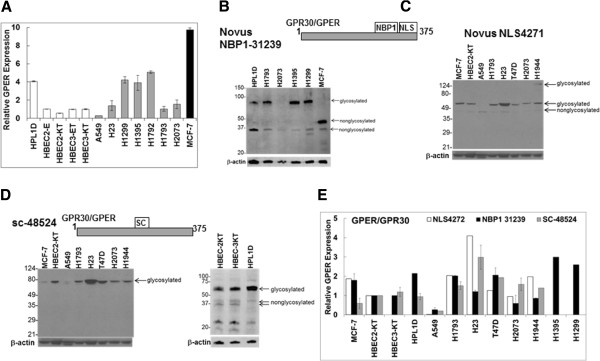
GPER/GPR30 expression in normal lung cell lines and lung adenocarcinoma cell lines. A) The expression of GPER was determined by realtime quantitative PCR in each of the normal lung cell lines (open bars), lung adenocarcinoma cell lines (grey bars), and MCF-7 human breast cancer cells (black bar). Values are the average of 4–6 biological replicates ± SEM. B-D) Representative western blot analysis of GPER/GPR30 expression in the indicted cell lines. 30 μg of whole cell extract (WCE) were separated on 10% SDS PAGE gels with MW marker migration indicated at the left of each blot. The diagrams at the top of B-C, and D indicate the region of GPER recognized by the 3 different polyclonal antibodies used: B) Novus NBP-1-31239, C) Novus NLS4271; D) Santa Cruz sc-4854-R. The MW of GPR30 is estimated to be 42 kDa, but higher MW sizes have been reported due to glycosylation and interaction with other proteins. Bands are identified as glycosylated and nonglycosylated based on reports cited in the text, but could include interaction with other proteins. For each GPER western, the membrane was stripped and reprobed for β-actin as a loading control. Quantitation of GPER was evaluated by summing all immunoreactive bands and dividing by β-actin, then normalizing to HBEC2-KT in each blot. Panel E is a summary of all westerns (not all westerns are shown) with each antibody. For Westerns with NBP1-31239 and sc-48524, values are the mean ± SEM from 3 separate blots using different WCE.